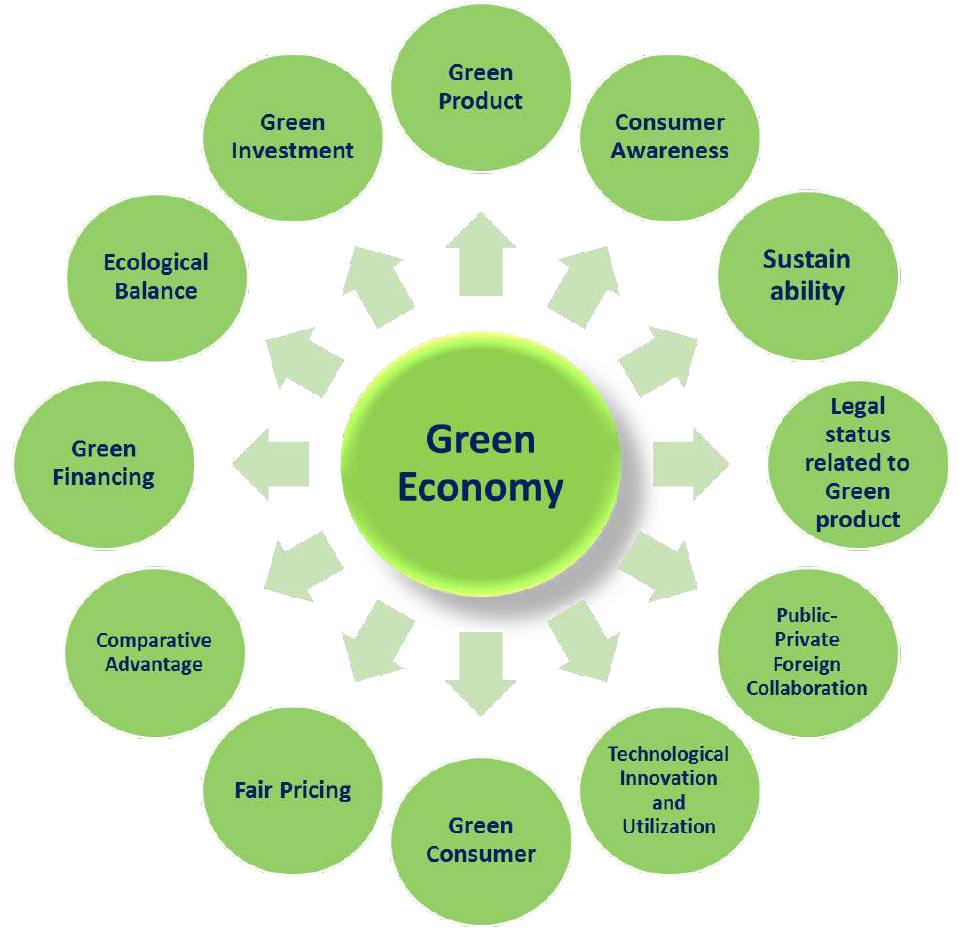
Fig. 1. Green economy and linkage with various